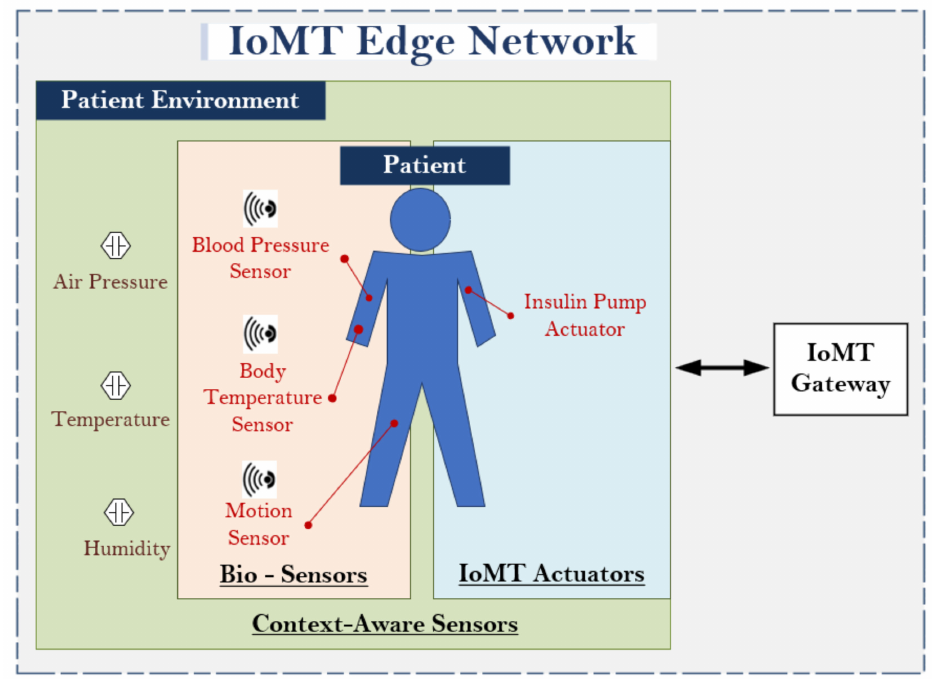
Figure 2. IoT-based health monitoring system perception